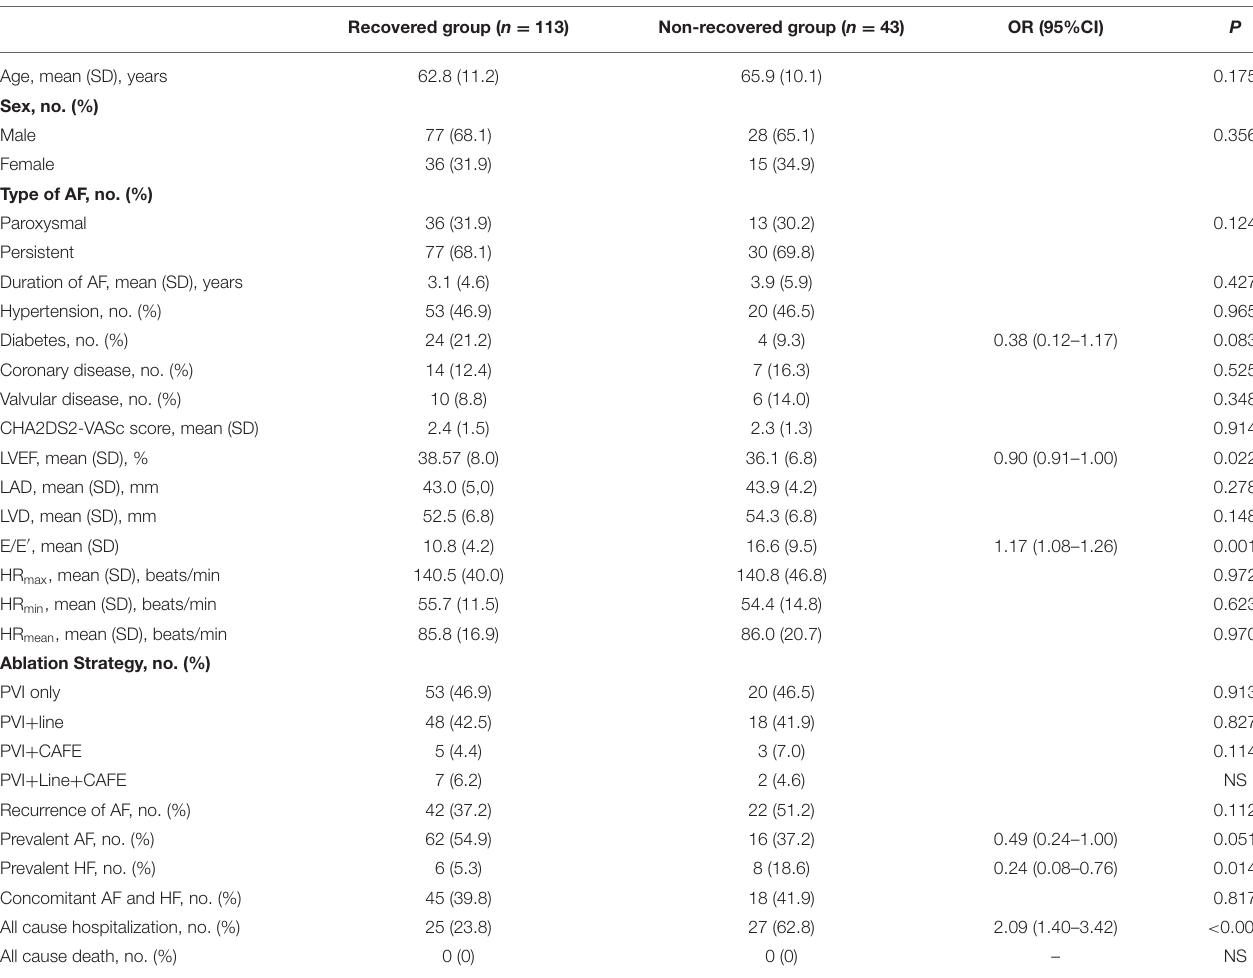
TABLE 2 | Univariate analysis of predictors of recovered ejection